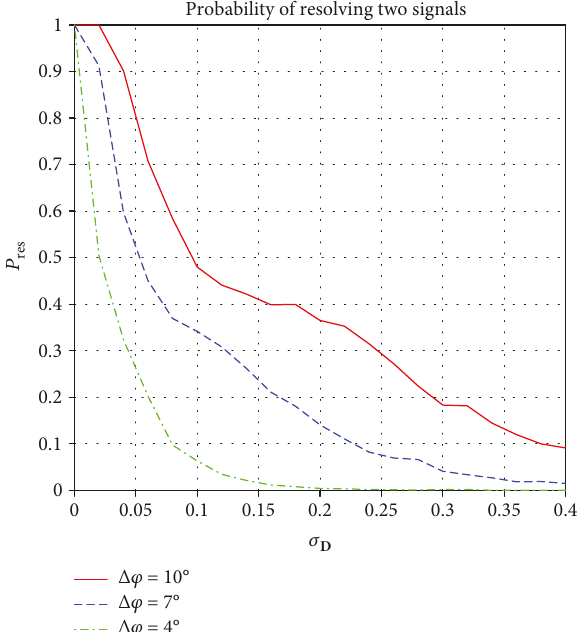
is in degrees. az